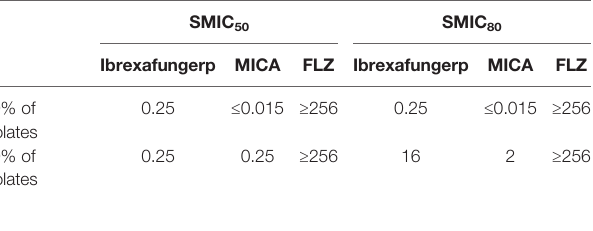
TABLE 4 | Sessile MICs at 50% and 80% reduction in the metabolic activity of the bio fi lm of 31 C . glabrata isolates (SMIC50 and SMIC80) following antifungal treatment compared to growth control (Pfaller M. et al., 2012).